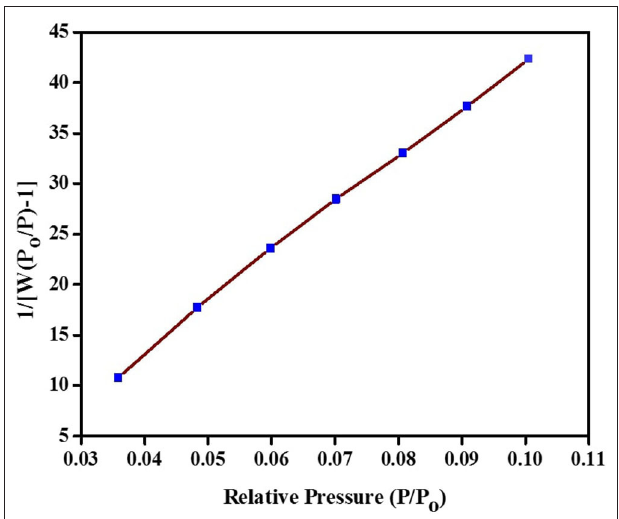
FIGURE 12 | PL spectrum of the synthesized green TiO 2